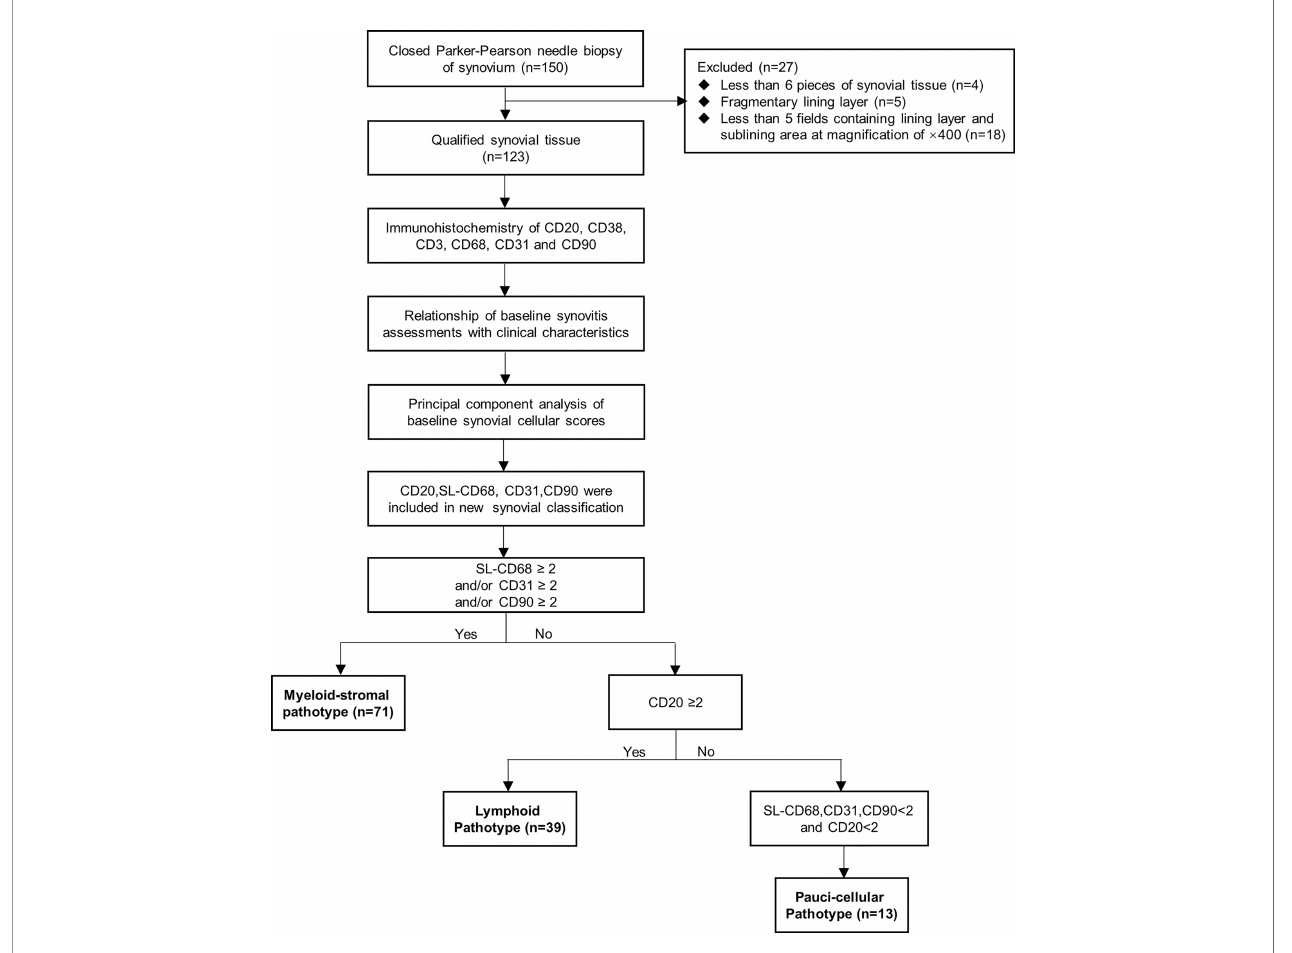
FIGURE 1 | Flow diagram of study